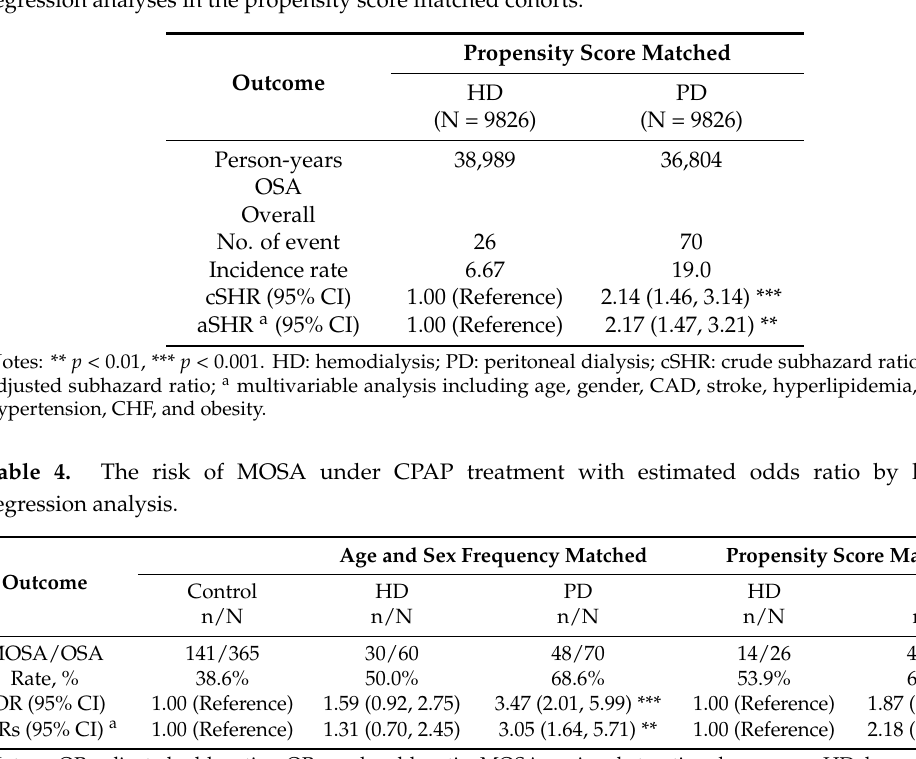
Table 3. Overall incidence (per 10,000 person-years) and subhazard ratio of OSA in competing risks regression analyses in the propensity score matched cohorts.